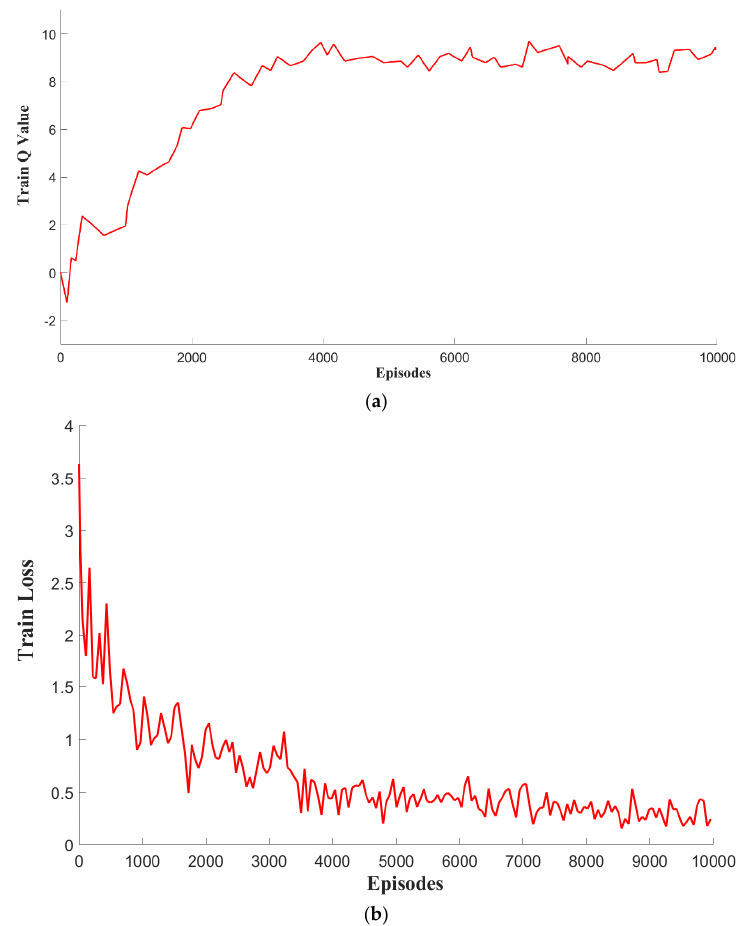
Figure 10. The evaluation of the proposed DRL model. ( a ) the average Q value curve for evaluating the stability of DSSTD model. ( b ) the loss value curve for evaluating the stability of DSSTD model.